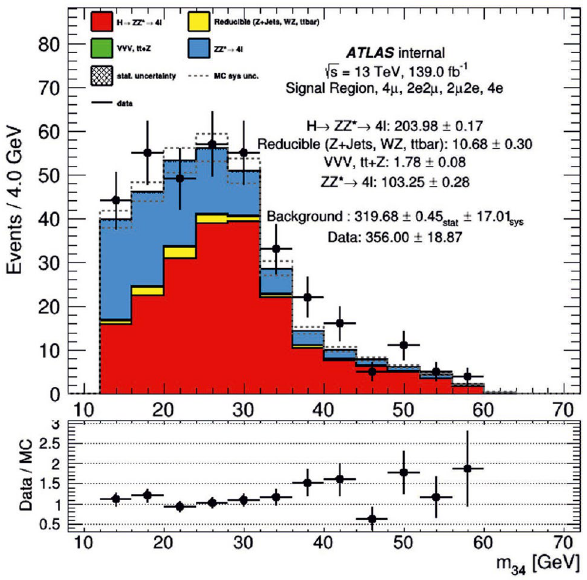
Figure 10. Original Data Distribution The distribution of H → ZZ ∗ → 4 l decay data as detected by the ATLAS